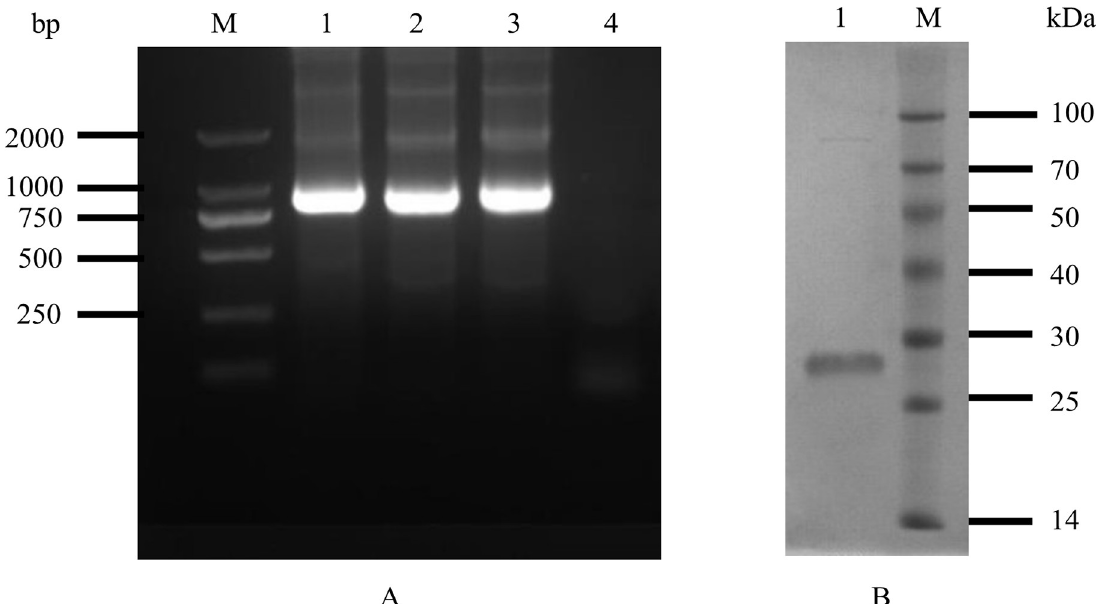
Fig 1. Electrophoretic images of gene amplification and PCR identification of recombinant plasmid (A) and M1 protein (B). ( A ) Lane M: DL2000; lane 1: the M1 gene was amplified with primers M1P1 and M1P2 using the H5N1 cDNA as a template; lanes 2 and 3: using the plasmid as a template, M1P1 and M1P2 amplification; lane 4, negative control; ( B ) Lane M: protein maker, lane 1: purified M1 protein.